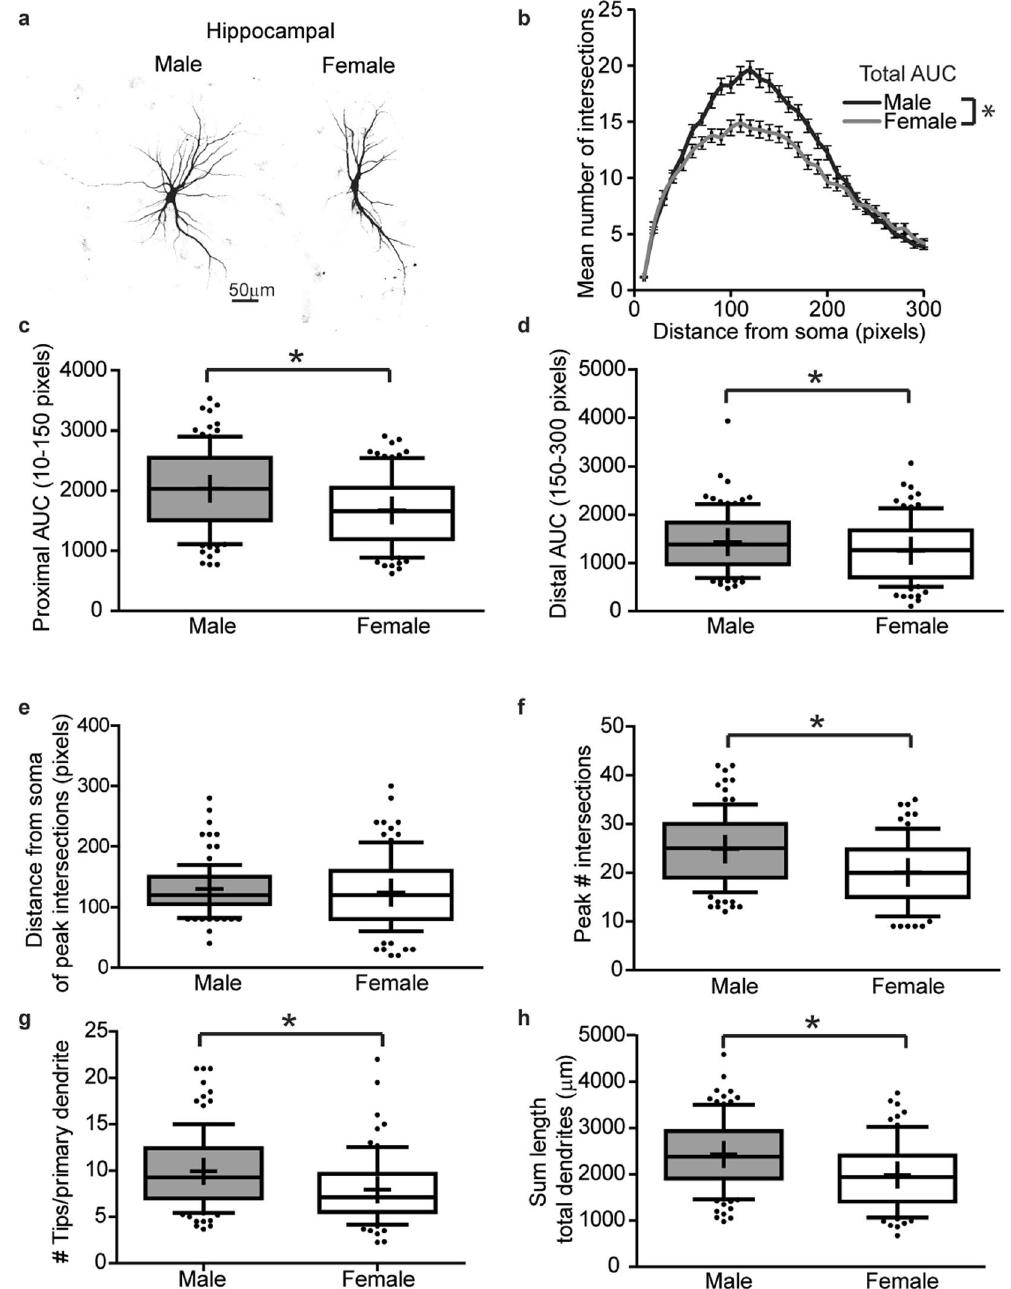
Figure 2. In vitro , dendritic arbors are more complex in male vs. female hippocampal neurons. Sex-specific neuron-glia co-cultures were established from P0 male and female mouse hippocampi, transfected with MAP2B-GFP plasmid on day in vitro (DIV) 6 and fixed on DIV 9. Representative images ( a ) and Sholl plot ( b ) of DIV 9 GFP-positive male and female hippocampal neurons. Dendritic morphology was assessed by quantifying: ( b ) the total area under the curve (AUC) in Sholl plots (10–300 pixels from the soma); ( c ) area under the proximal portion of the Sholl curve (10–150 pixels from the soma); ( d ) area under the distal portion of the Sholl curve (150–300 pixels from the soma); ( e ) distance from the soma at which the peak number of dendritic intersections occurs; ( f ) the peak number of dendritic intersections; ( g ) the number of terminal dendritic tips per primary dendrite; and ( h ) the total dendritic length per neuron. In the box plots ( c – h ), “ + ” indicates the mean; whiskers, the 10–90 th percentile, (n = 76–101 neurons per sex from at least five independent dissections). Significant differences were determined using Student’s T-test for parametric data ( b , c , f , h ) and Mann-Whitney U test for nonparametric data ( d , e , g ). Asterisk indicates a significant difference between groups at p ≤ 0.05. AUC = area under the curve. Magnification; 0.65 microns per